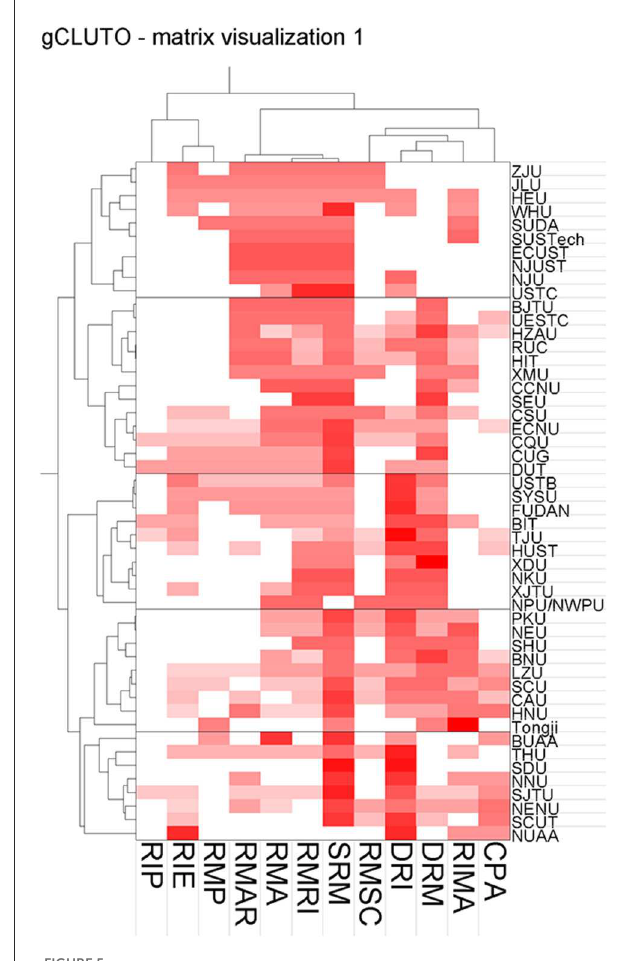
FIGURE5 Clustering results of RI policy themes in higher education institutions (CPA, Code of Policy Application; RIMA, Research